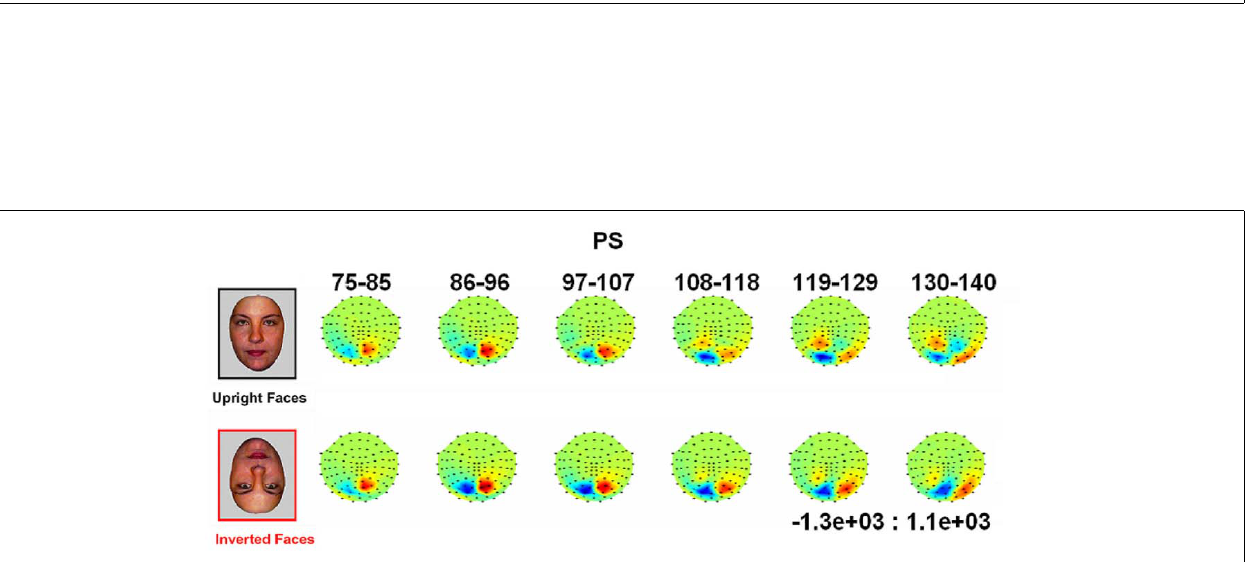
FIGUREA7 | Evoked responses averaged across three channels for the more inferior left and right ROIs in Experiment 1 (see Figure 9 for more superior ROIs). These channels were chosen as those with the maximal negative deflection vs. baseline in the left hemisphere from 120